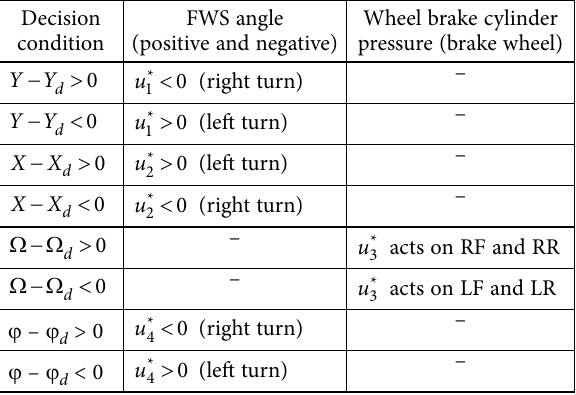
Table 1. The general control rules of the trajectory-tracking